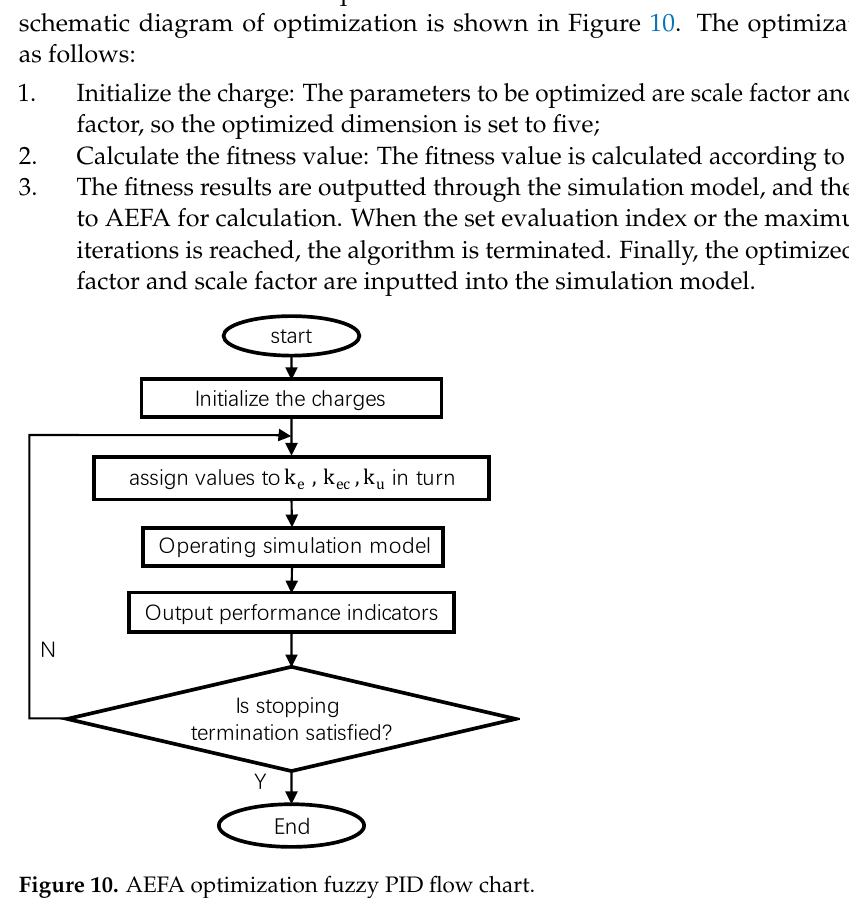
Figure 10. AEFA optimization fuzzy PID flow chart.